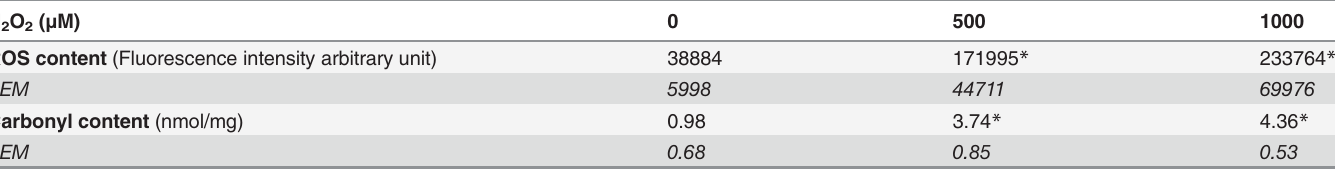
Table 2. Effect of H 2 O 2 on ROS and carbonyl contents.